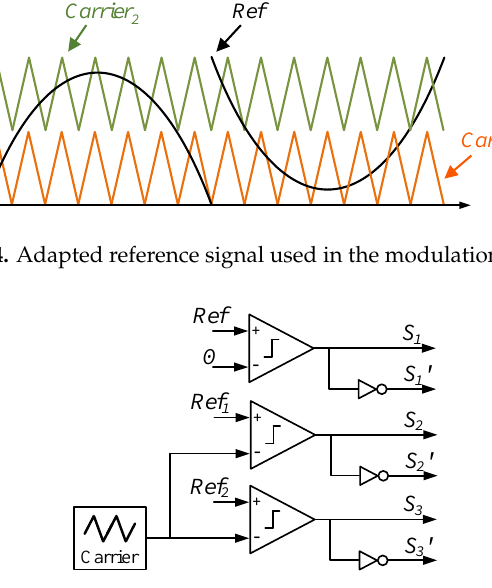
Figure 5. Sinusoidal Pulse-Width Modulation (SPWM) signals generation based on the adapted reference signals.